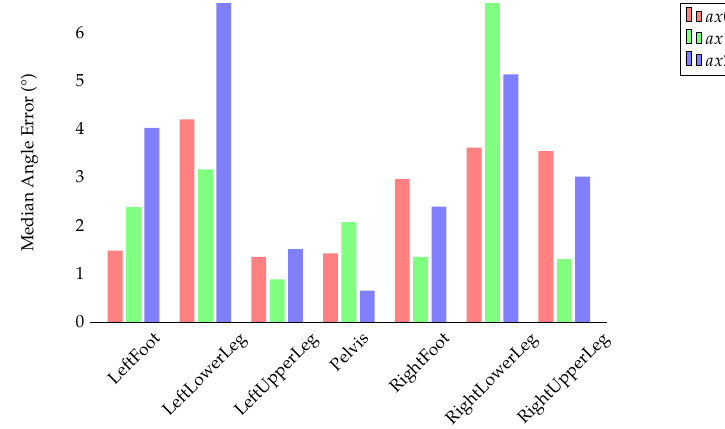
Figure 15. Evaluation results for the I2S alignment problem using the final model (based on all datasets). The bar plots show the median angle errors around the three body segment axes over all windows, considered test persons and IMU